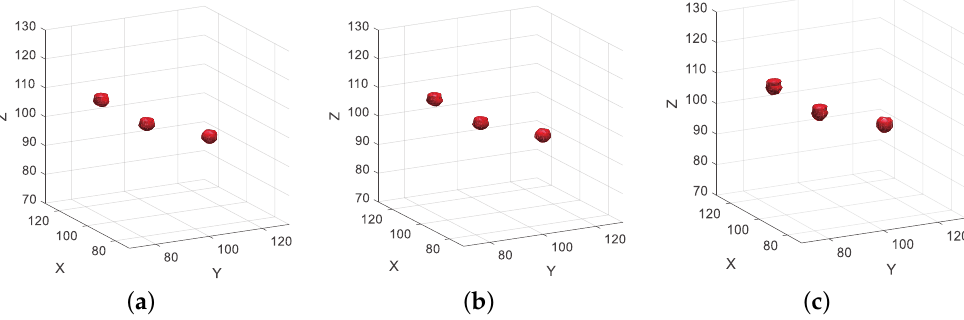
Figure 8. Imaging results with different sample rate data. ( a ) 100% sampled data. ( b ) 25% wave number sampling data. ( c ) 25% scan plane sampling data.